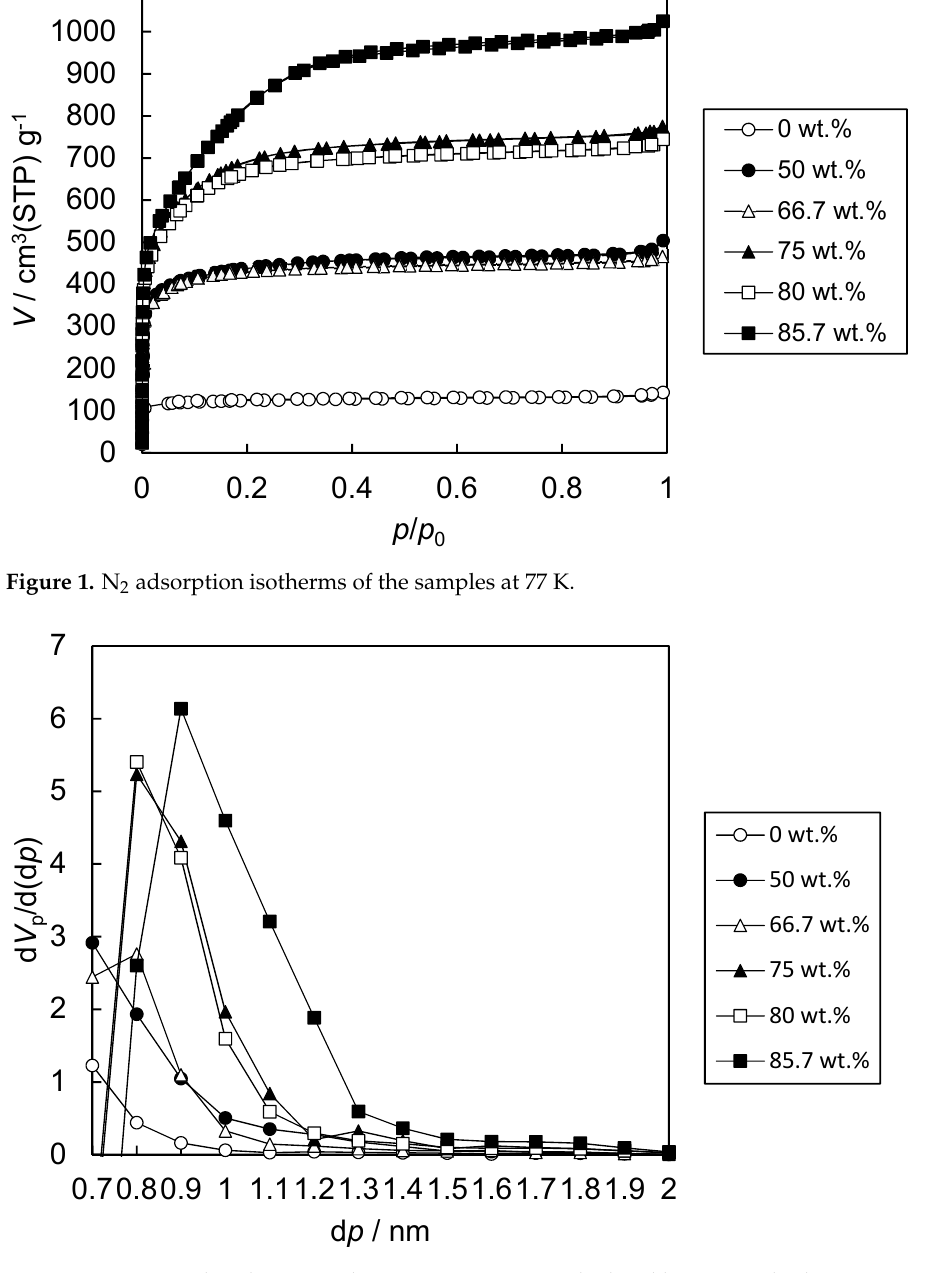
Figure 2. Pore size distribution at the micropore region calculated by MP method.